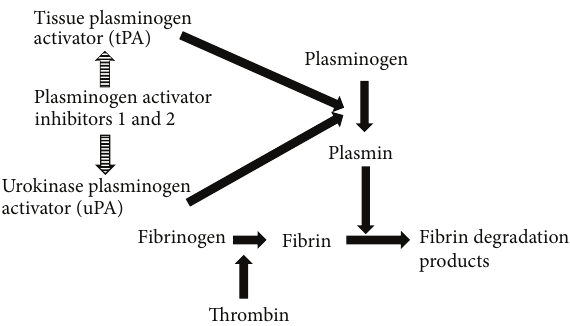
Figure 1: Role of PAI-1 in fibrinolytic